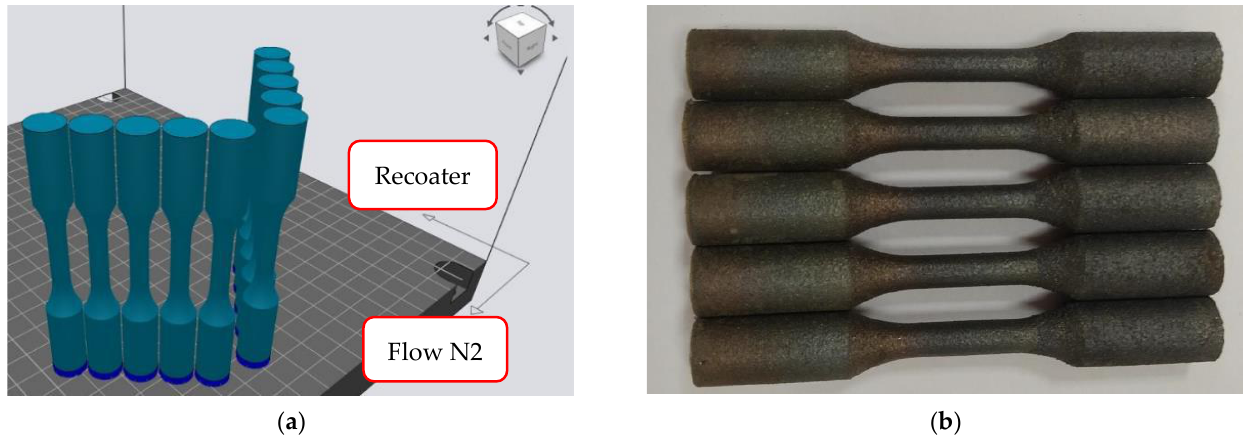
Figure 7. ( a ) Orientation of the samples in the printer workspace; ( b ) Printed test samples for tensile test.